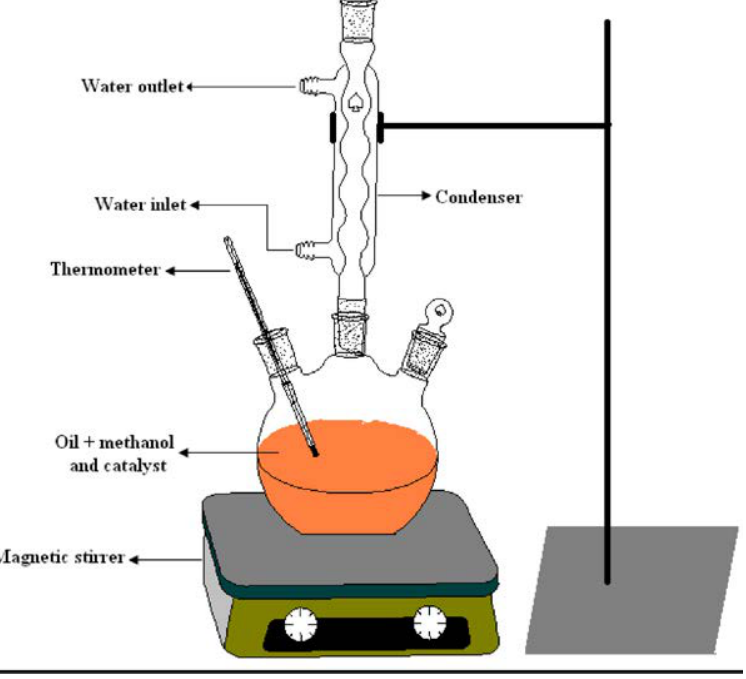
Figure 9. Schematic diagram of transesterification